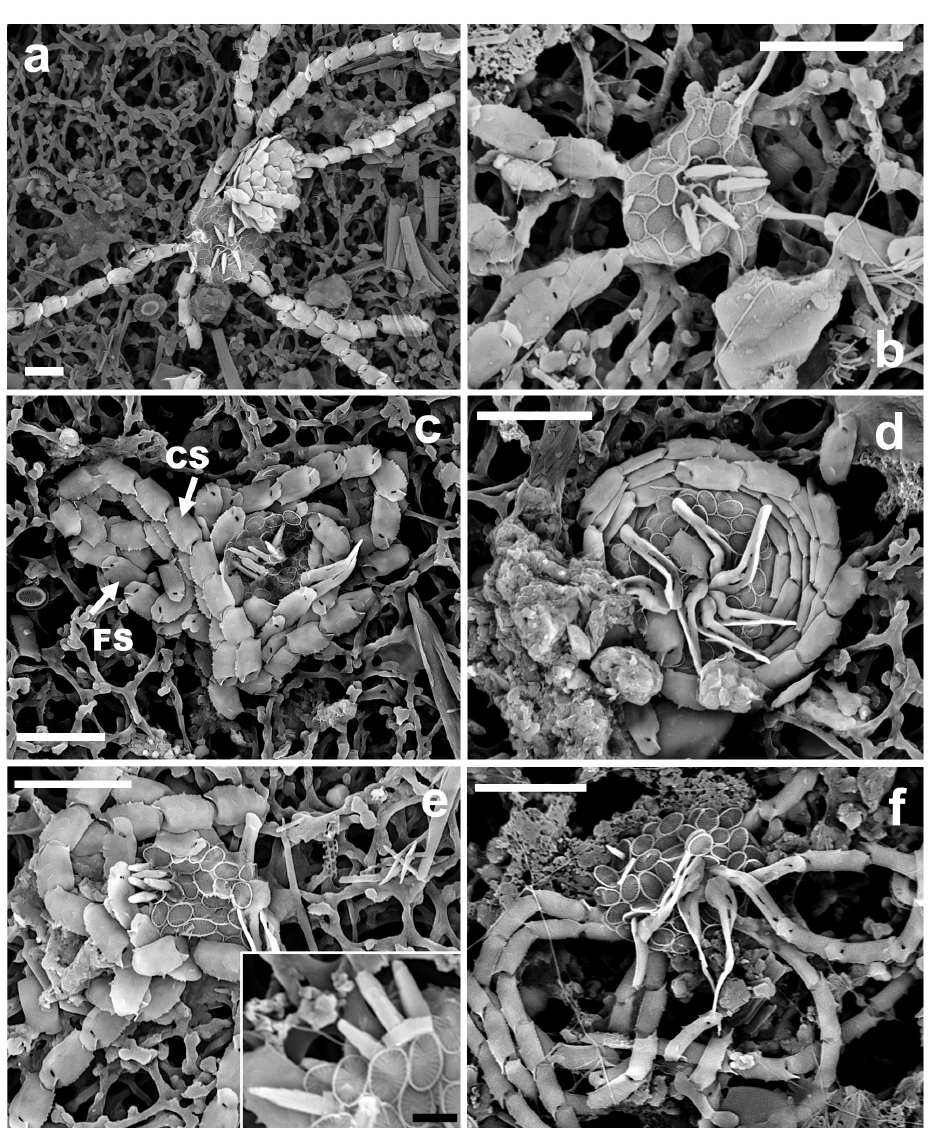
Figure 9. Ophiaster macrospinus . (a) Apical view with an overlapping Florisphaera coccosphere (GoA, 11 September 2017, 120m). (b) Apical view showing connection of body coccoliths, link coccoliths and osteoliths, as well as the difference in wall height between body and circum-flagellar coccoliths (GoA, 18 June 2017, 120m). (c) Arrows indicate the convex (CS) and the flat side (FS) of the osteoliths (GoA, 11 September 2017, 120m). (d) O. macrospinus wrapped arms, with a view of link coccoliths (GoA, 11 September 2017, 120m). (e) View of coccosphere with body coccoliths, central spines and surrounding osteoliths. A close-up of the central robust spines is shown in the inset (GoA, 11 September 2017, 120m and GoA, 17 August 2020, 120m). (f) Coccosphere of O. formosus with narrower osteoliths and smaller spines on circum-flagellar coccoliths (GoA, 18 October 2017, 80m). Scale bars: 5µm, insertion: 1µm.